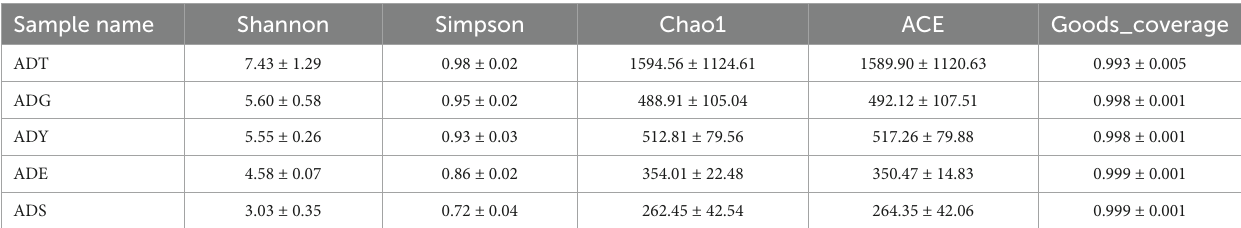
TABLE 2 Microbial diversity index